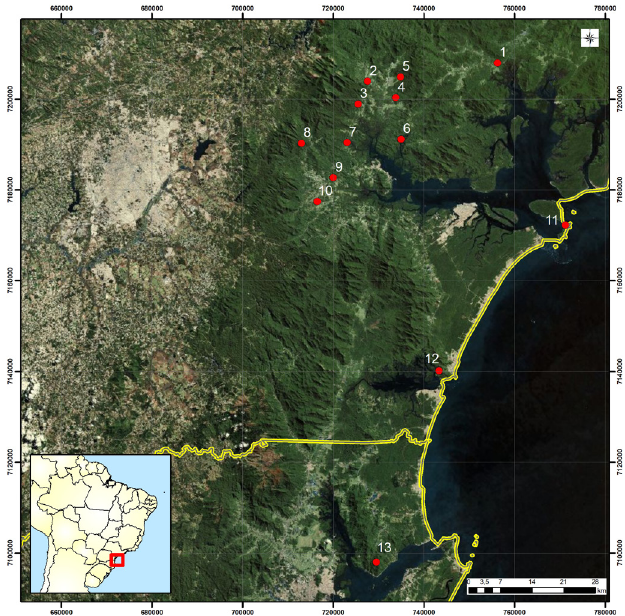
Chironius fuscus Figure 1. Localities of record of in the states of Paraná (PR) and Santa Catarina (SC). Municipality of Guaraqueçaba: 1 -